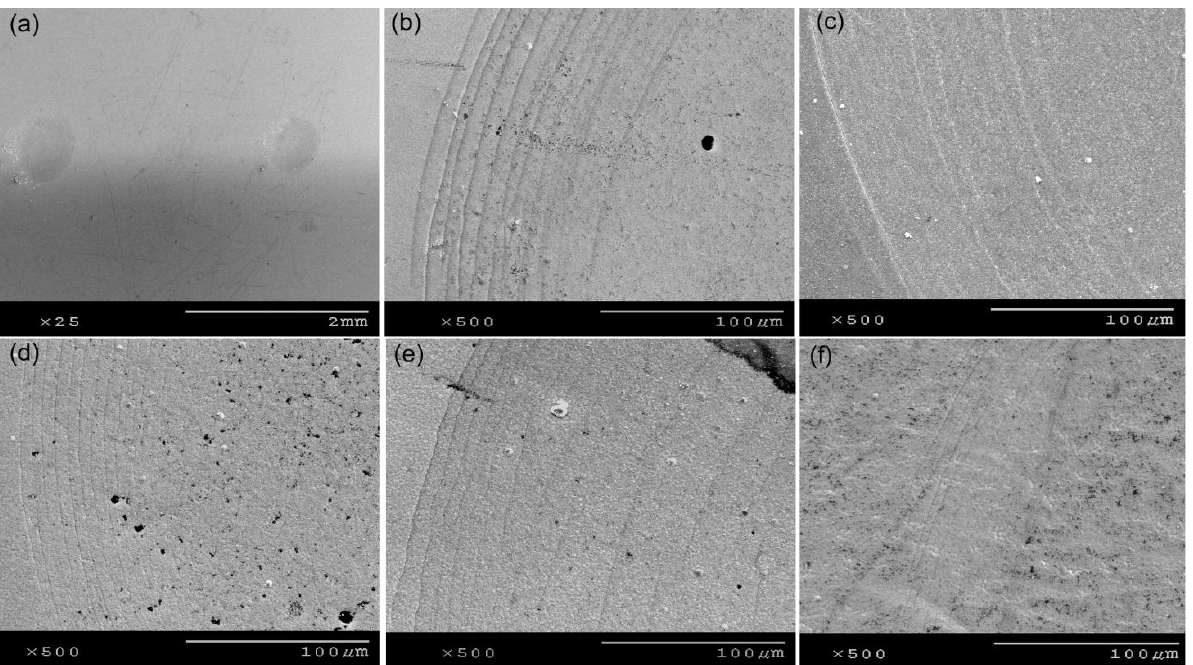
Figure 7. SEM images showing extent of circumferential cracking on ( a ) NCD with 60